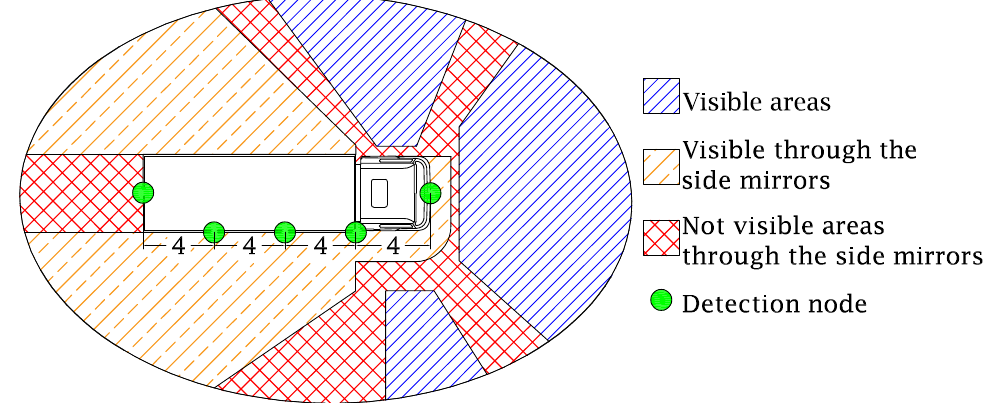
Figure 1. Truck with all detection nodes (green dots) mounted and all blind spots around a truck. Double blue lines are areas visible through the windshield, the orange solid and dashed lines are the areas visible through the side mirrors and the red crossed lines are not visible through the side mirrors, also known as the blind spot